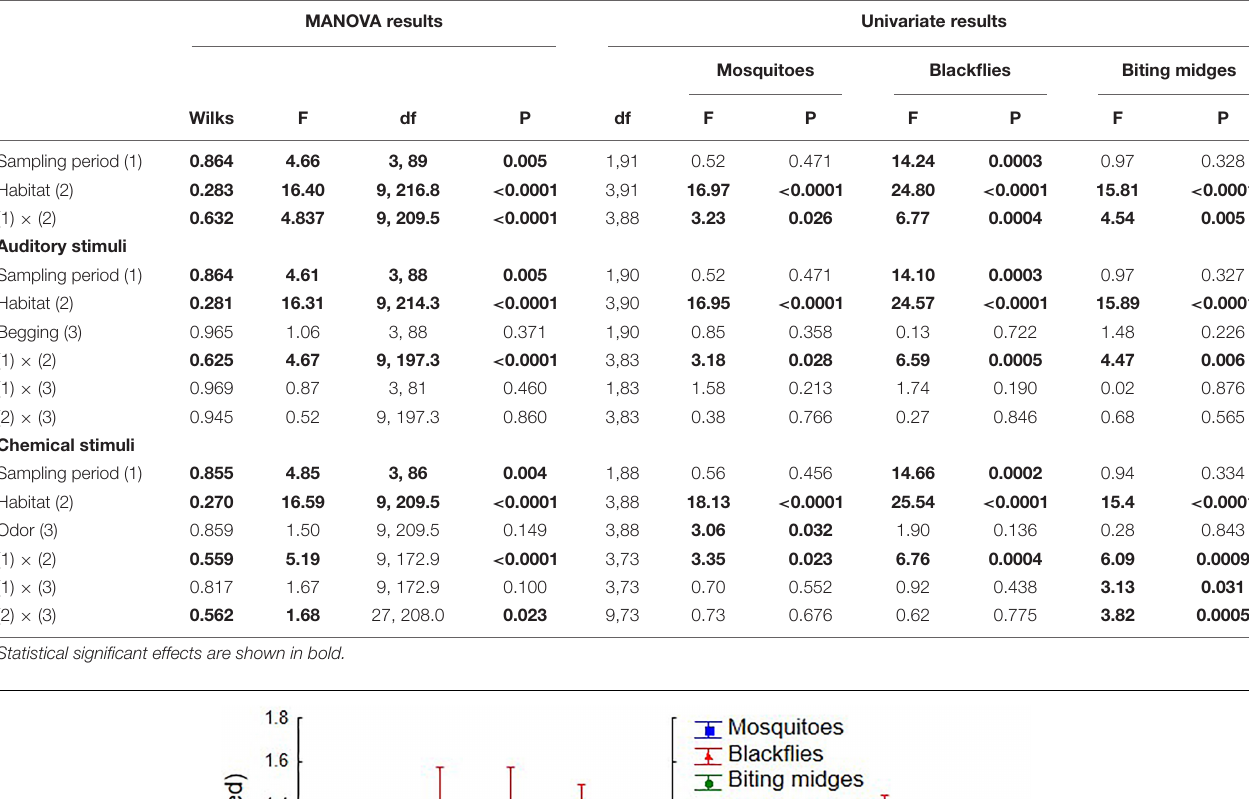
TABLE 3 | Results from multivariate and univariate ANOVA exploring the effects of sampling period and habitat, together with the experimental effect of auditory and chemical stimuli, on abundance of blood-feeding flies collected in traps. MANOVA results